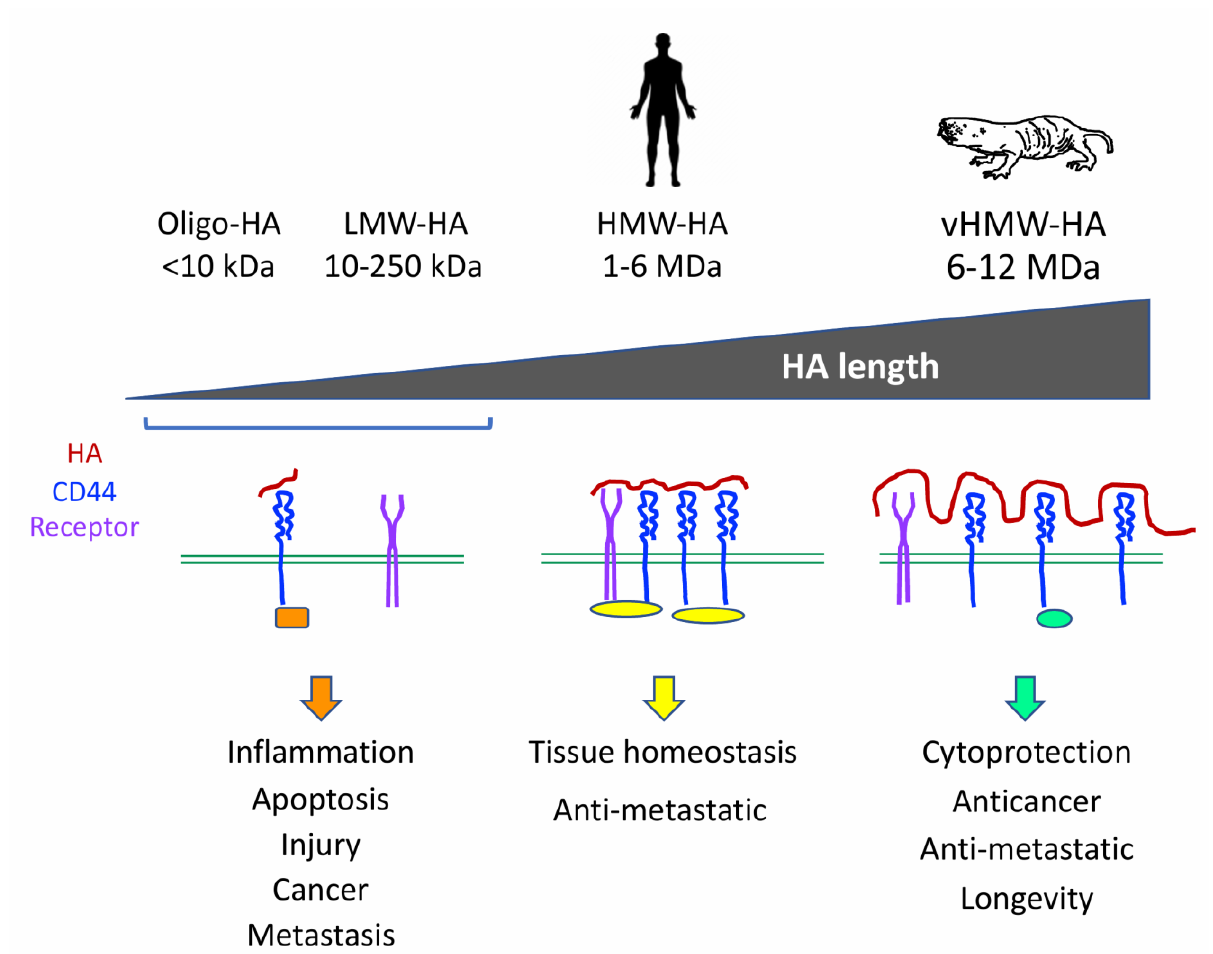
FIGURE 1: Biological effects of hyaluronans of different length. Hyaluronans of different length affect receptor interactions on cell surface and consequently engage different adaptor proteins (colored ovals and squares) on the cytoplasmic side activating distinct signaling path- ways. Oligomeric hyaluronan (Oligo-HA) and low molecular weight hyaluronan (LMW-HA) do not cause clustering of CD44 (blue) and other receptors (purple). These hyaluronans are associated with inflammation, sites of injury, and promote cancer growth and metastasis. High molecular weight hyaluronan (HMW-HA) found in human tissues and in most other mammals, induces clustering of receptors and this signal- ing promotes tissue homeostasis, cell adhesion, and prevents metastasis by keeping cells in place. Very high molecular weight hyaluronan (vHMW-HA) is found in the naked mole rat. This hyaluronan shields CD44 receptor from interaction with other proteins leading to distinct downstream signaling characterized by cytoprotective effect, suppression of apoptosis. vHMW-HA has anticancer properties by limiting cell proliferation and metastasis and may ultimately promote longevity by protecting tissues from